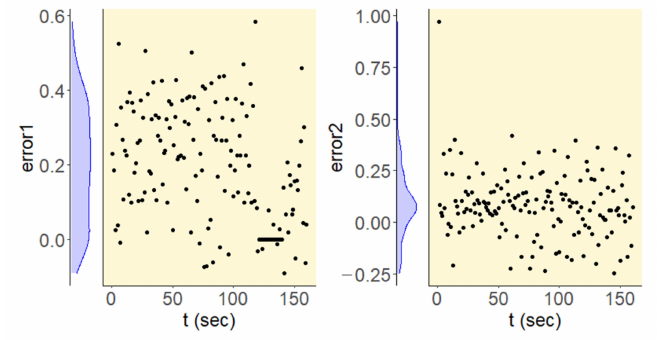
Figure 13. Flow conservation error in the actual data at the intersection